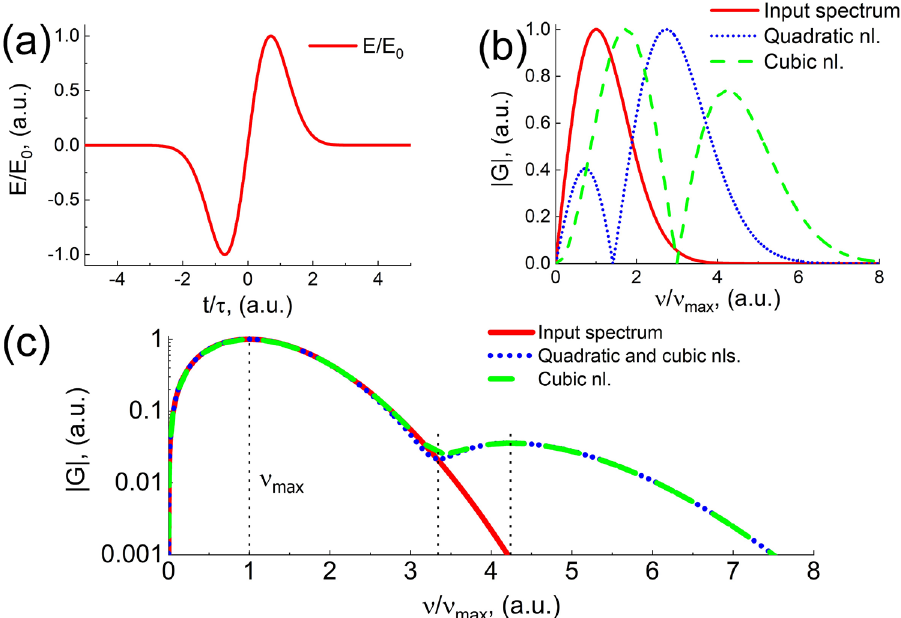
Figure 2. ( a ) Electric field of a THz single-cycle pulse (Eq. 2). ( b ) The THz pulse spectrum modulus at the input of the medium (the red curve, Eq. 10), modulus of second-order nonlinear contribution (the blue dotted curve, Eq. 12), modulus of third-order nonlinear contribution (the green dashed curve, Eq. 11). ( c ) Modulus of the THz pulse spectrum at the input of the medium (the red curve, Eq. 10) and the spectrum of the THz pulse at the output of the medium with (the blue dotted curve) and without (the green dashed curve) taking into account the second-order nonlinearity (Eq. 9). The position of the maximum frequency ν max of the THz radiation is